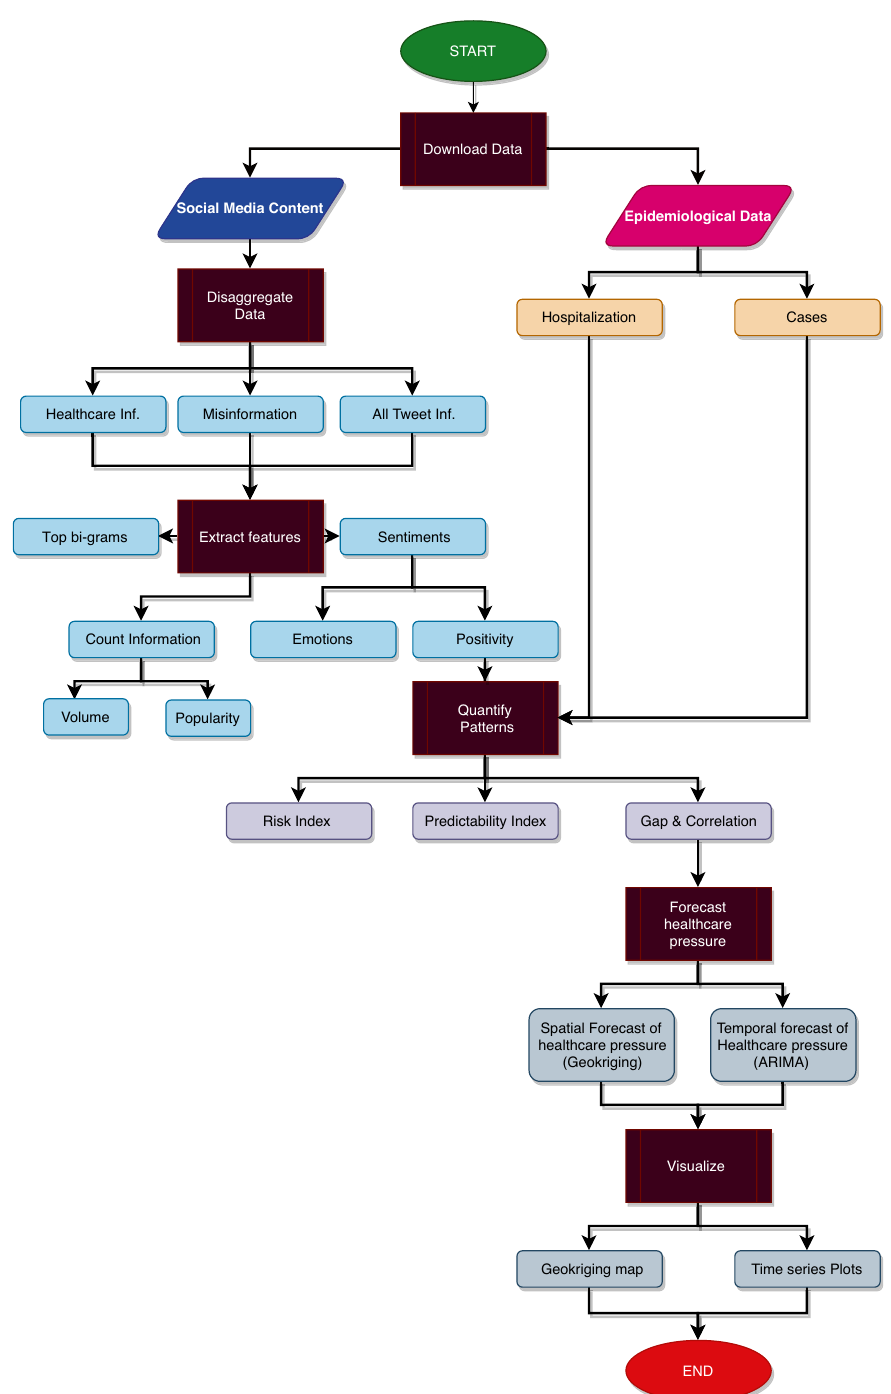
Figure 1. Conceptual and computational workflow of InTo. The process begins with downloading both social media content and epidemiological data. Social media data is then disaggregated into content related to healthcare and misinformation, with the aggregated content retained for analysis as well. As for epidemiological data, the dashboard makes use of hospitalization and cases data for the disease considered. The next process is the extraction of features from social media content: for each subset, bi-grams, count information and sentiments are quantified. Metrics quantifying the relationships between sentiment and epidemiological data are then calculated. Once the linear regression coefficients are estimated (considering the linearity found at the weekly scale between positivity and hospitalization as well as cases; however further non-linear models can be used), these are used to forecast the spatial and temporal variation of healthcare pressure, which is then visualized for users on the dashboard. To illustrate the process and output of InTo we examine the case of New Delhi and Mumbai in